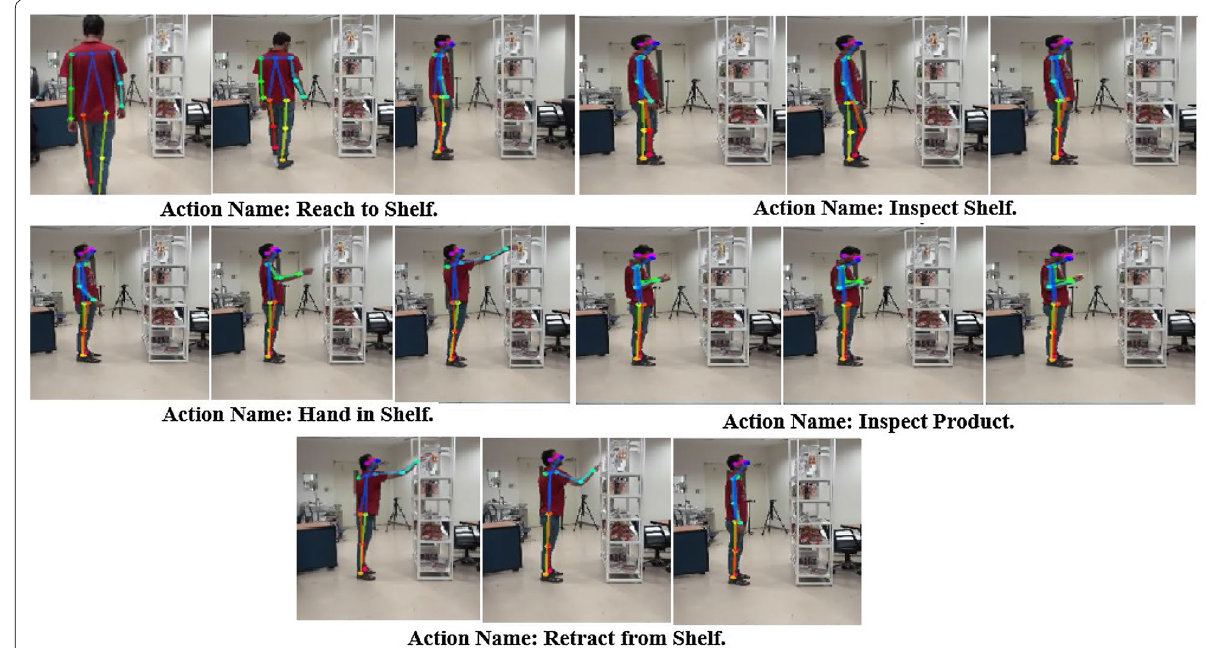
Fig. 1 Examples of customer